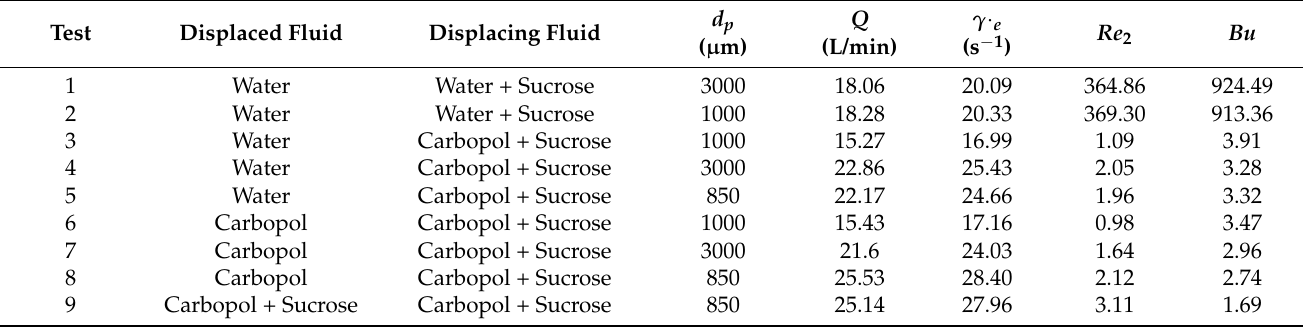
Table 5. Overview of the performed